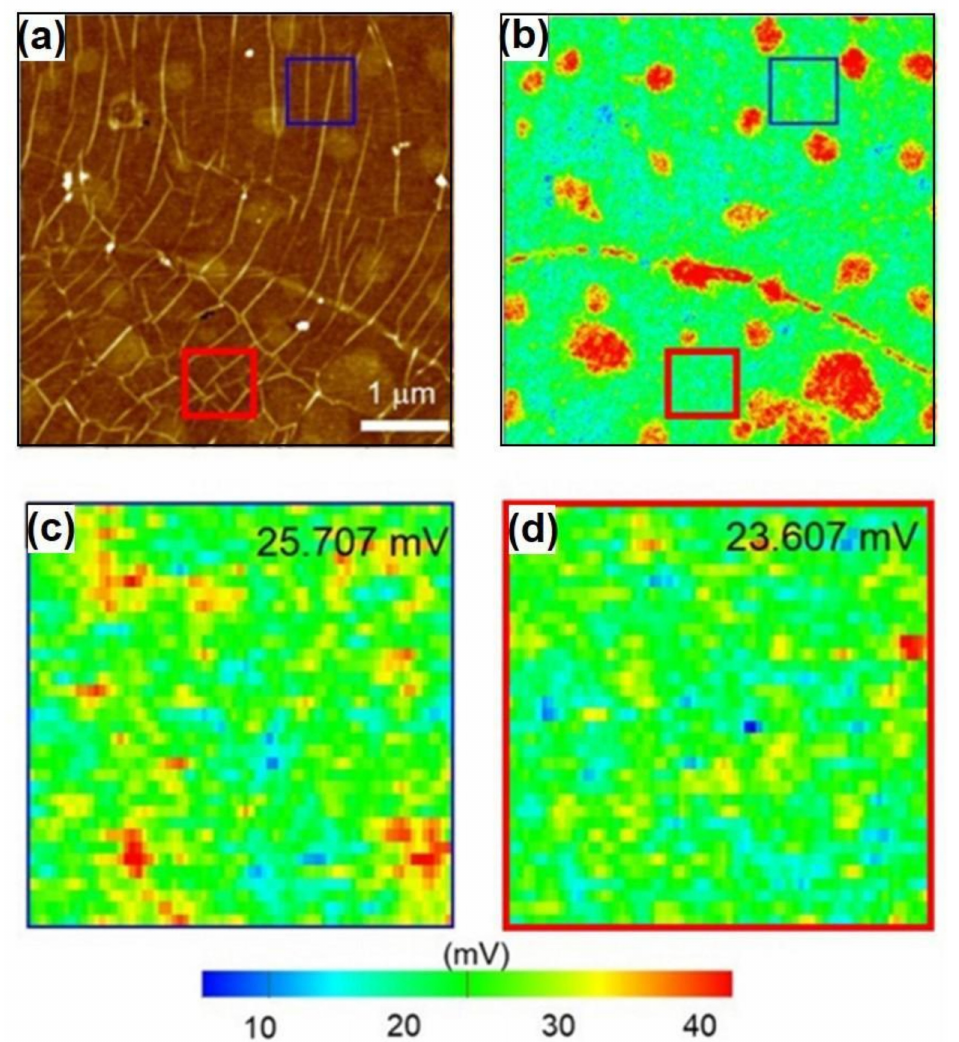
Figure 12. ( a ) The AFM image revealed both the threading (blue square) and surrounded type RPs (red square). ( b ) The corresponding EFM image simultaneously obtained with AFM. Silicone adhesive regions in ( b ) were not considered. The ( c , d ) were zoomed-in EFM images at each chosen region with averaged EFM tapping amplitude voltage values written in upper-right positions. Reprinted with permission from ref.